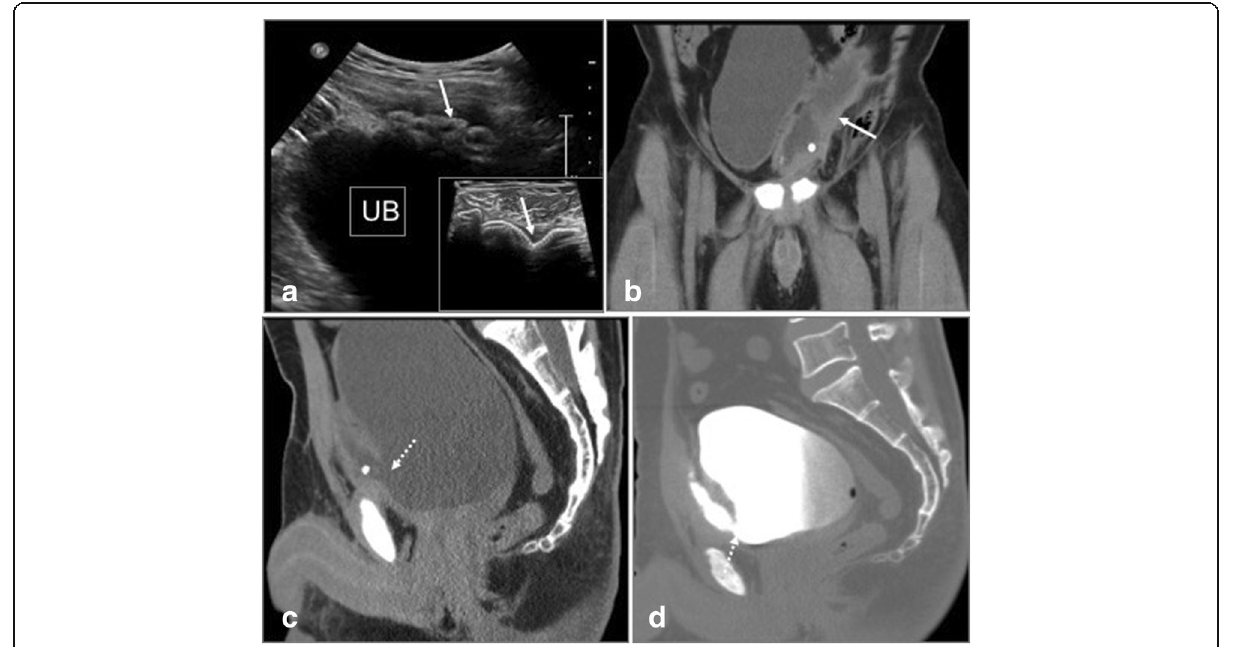
Fig. 15 Post left inguinal hernia repair. a USG shows collection with migrated mesh (arrows) close to the urinary bladder (UB). b , c CT in coronal and sagittal planes show mesh eroding the anterior wall of urinary bladder (arrow) with fistulous communication (dashed arrow). d CT Cystogram confidently demonstrates the bladder communication (dashed